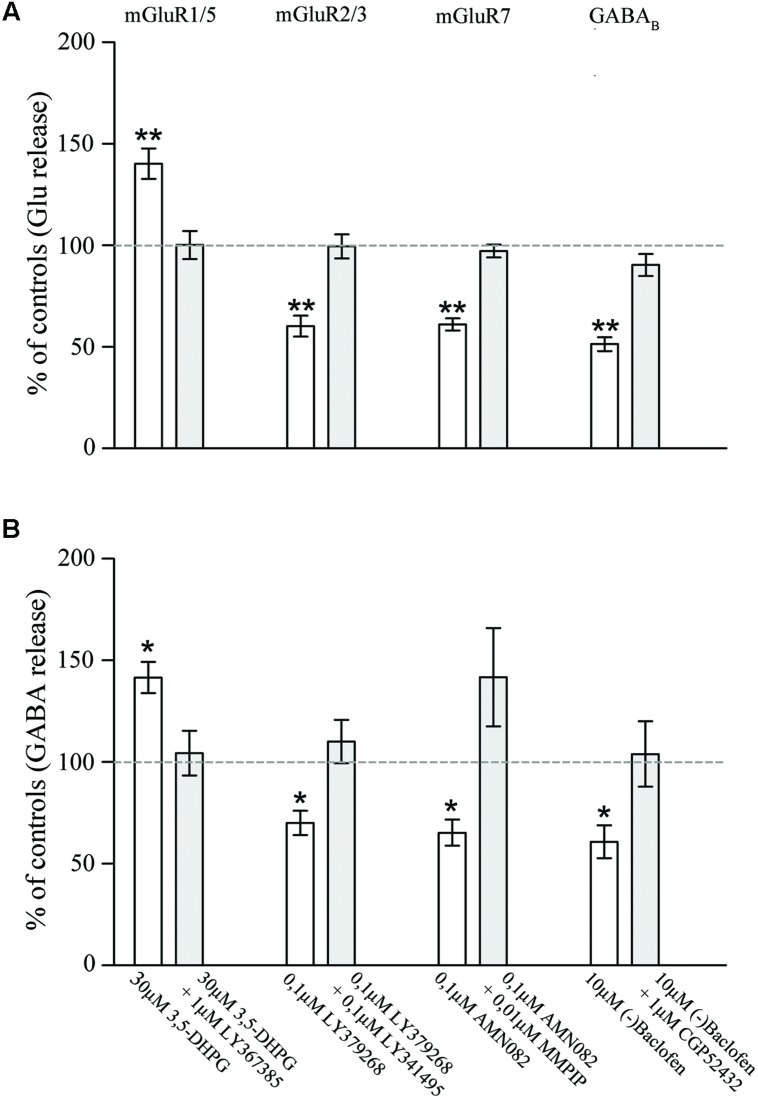
Effect of agonists and antagonists of mGluR1/5, mGluR2/3, mGluR7, or GABAB receptors on the release of endogenous glutamate (A) and GABA (B) from rat parietal cortex synaptosomes. Data are expressed as percent of the spontaneous outflow (mGluR1/5 effect) or of the 15 mM KCl-evoked overflow (mGluR2/3/7 and GABAB effects). White and gray columns refer to agonist or agonist + antagonist administration. Data are means ± SEM of 6–10 independent experiments (6–10 rats per group). ∗p < 0.05 and ∗∗p < 0.01 vs. controls.